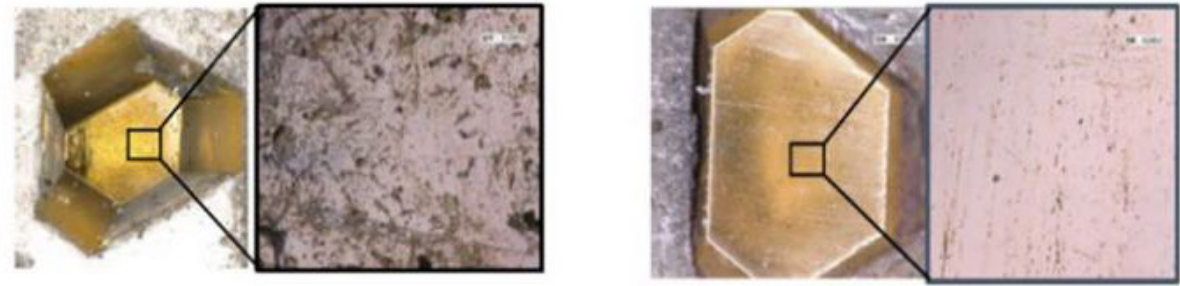
Figure 7. Surface condition before and after diamond abrasive grinding [17].